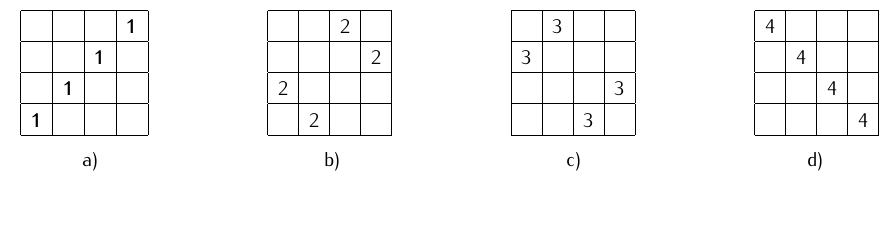
Figure 3. The Latin supersquare of order c)